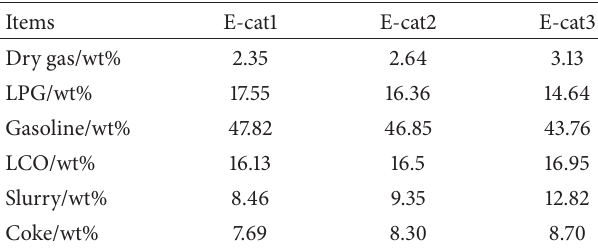
Table 1: ACE results of E-catalysts.